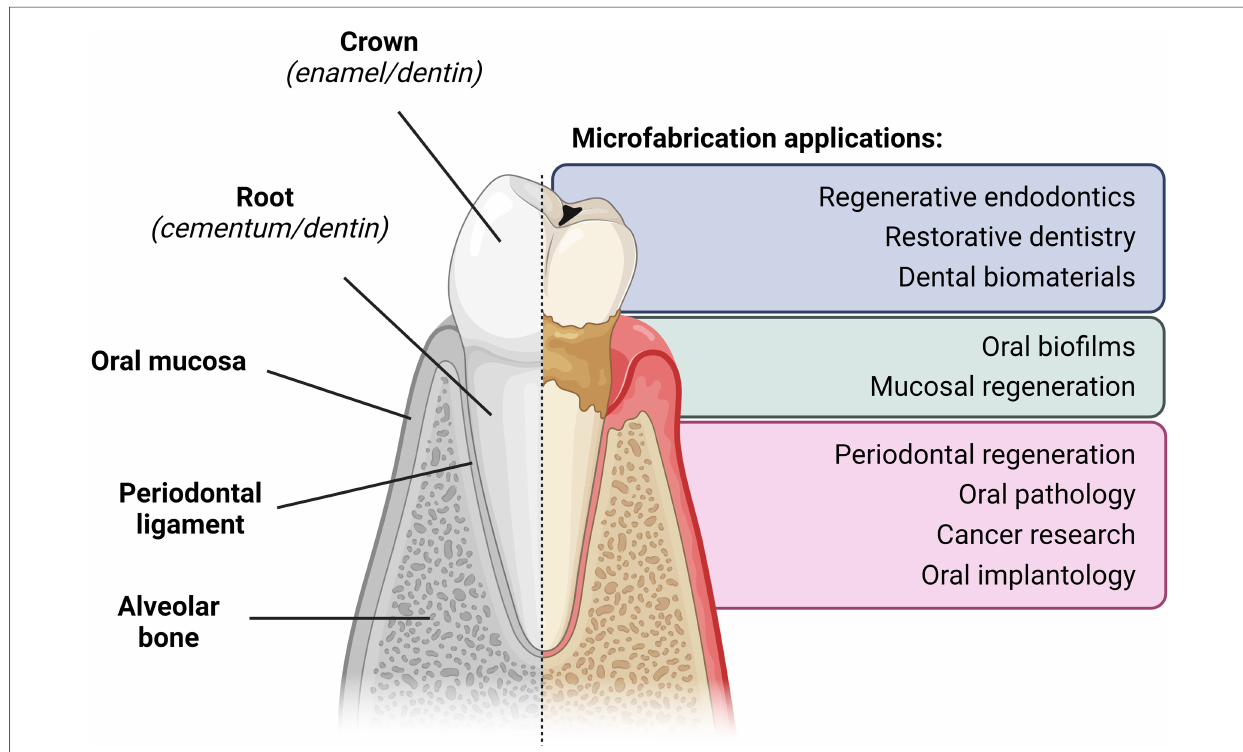
FIGURE 1 Summary of current research applications of microfabrication in dental research. Spatial architecture of the dental and periodontal tissues, as well as the main current applications of microfabrication-based approaches for the study of oral diseases and